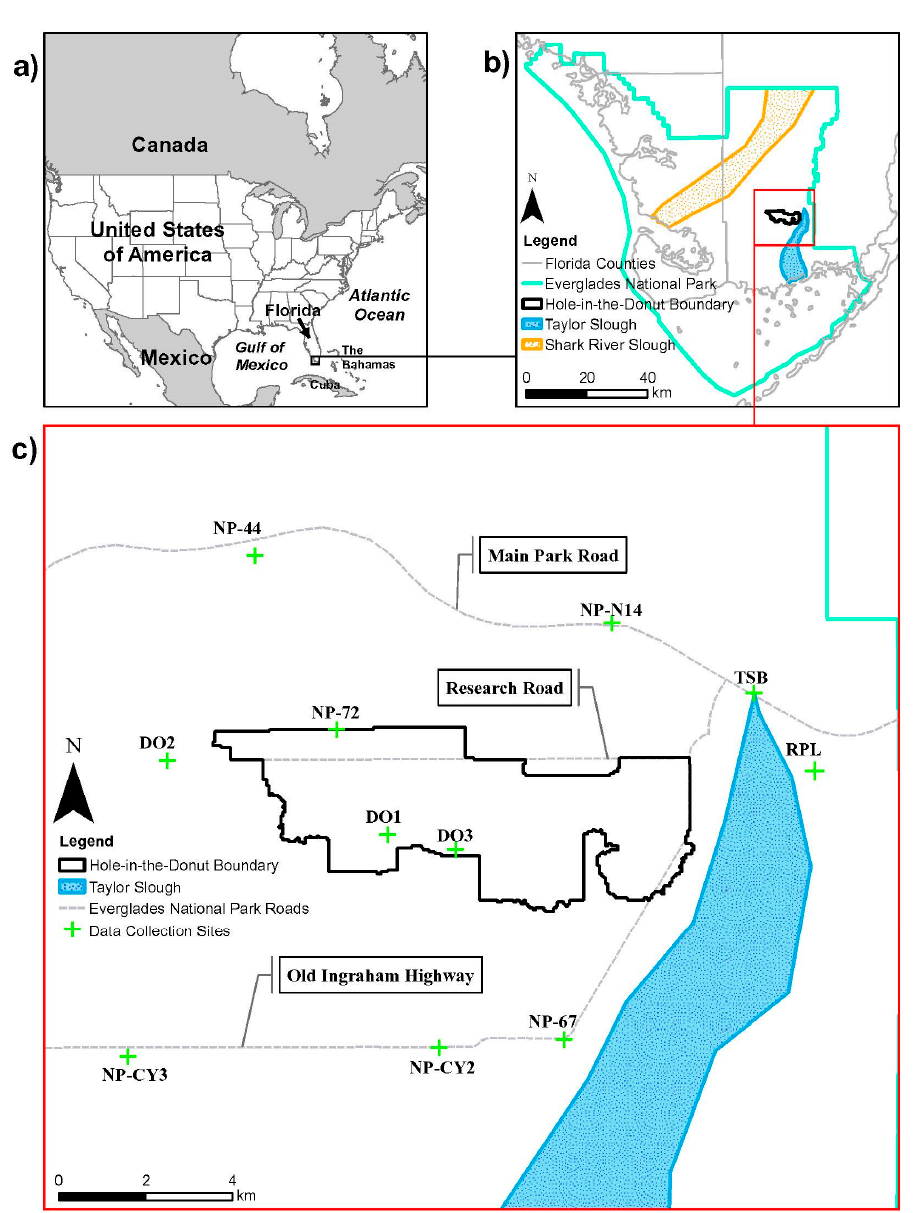
Figure 1. The location of the Hole-in-the-Donut area of Everglades National Park (ENP), Florida, USA. Adapted from [42]. The green crosses represent long-term hydrologic data collection sites within ENP.